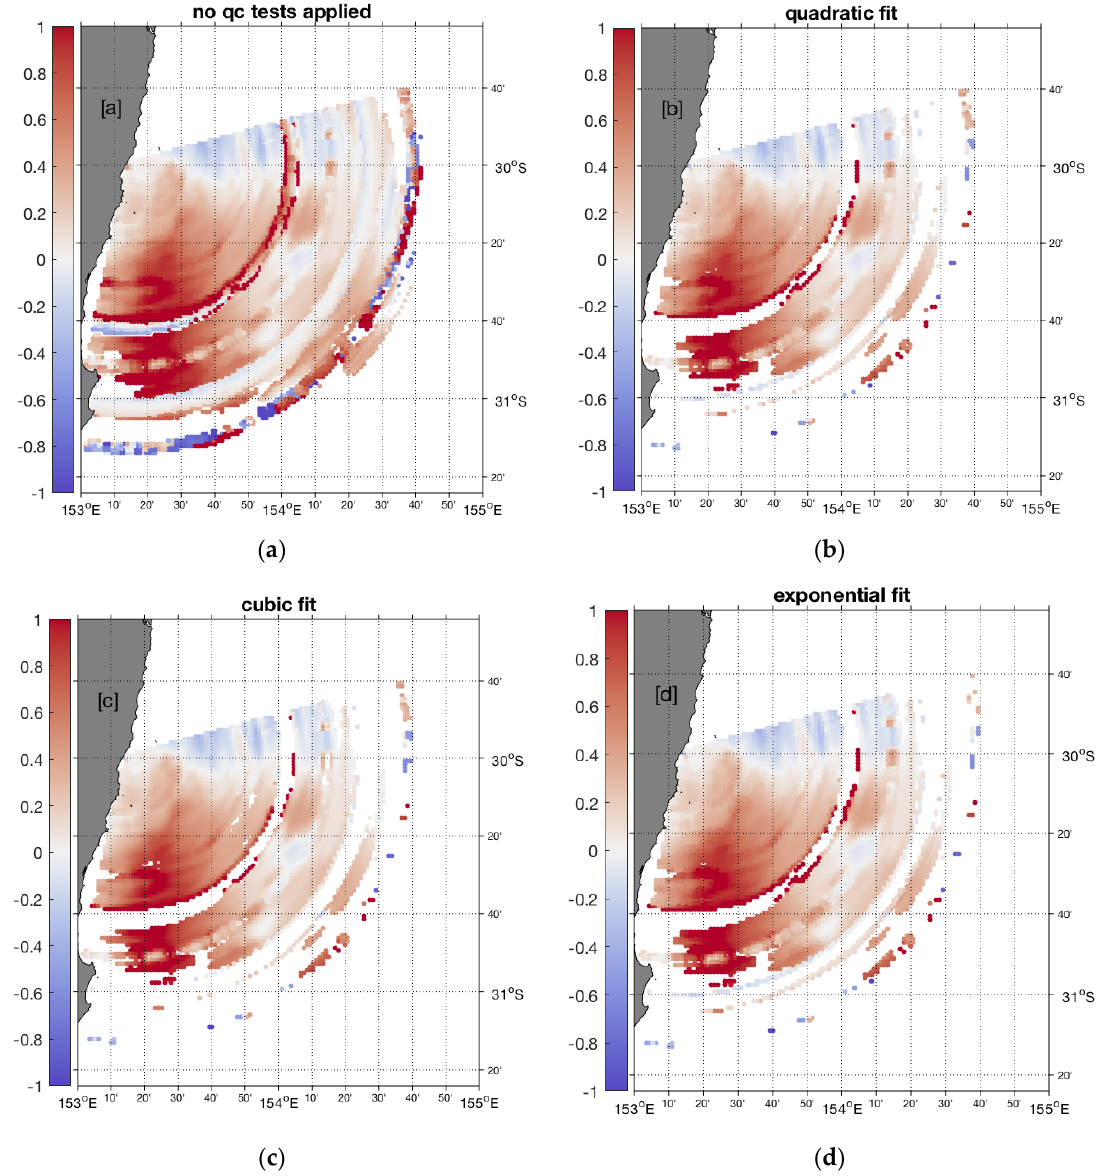
Figure 6. Effects of the proposed QC methodology on radial velocity map from the RRK HFR station: ( a ) no QC applied; ( b ) quadratic 1-D fit; ( c ) cubic 1-D; ( d ) exponential decay 1-D fit. (b–d) also include threshold on radial velocity and SNR. Units for radial velocity are m/s.